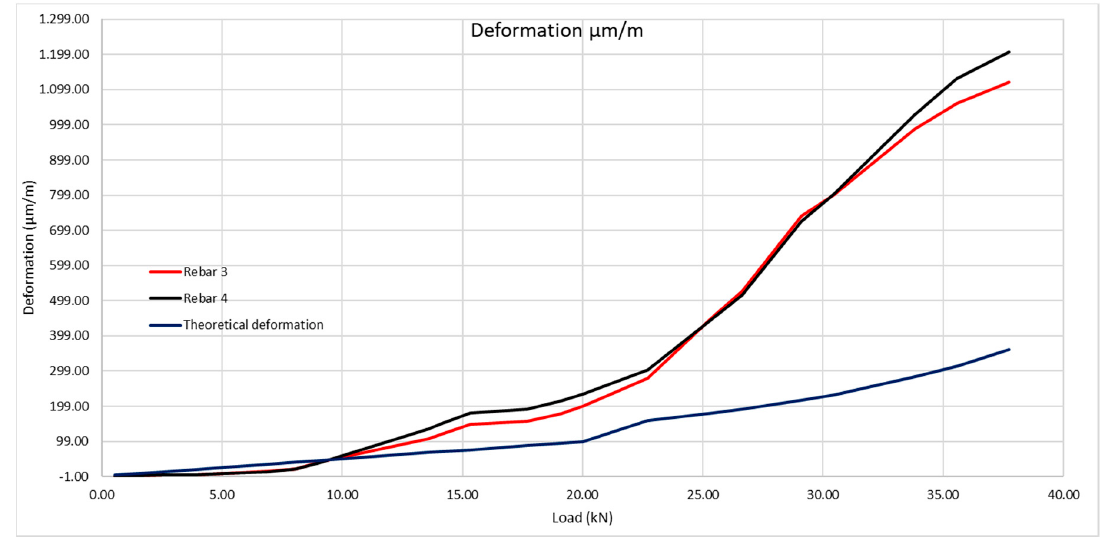
Figure 15. Theoretical deformation of the rebars compared with real deformation obtained with the optic fiber sensors.